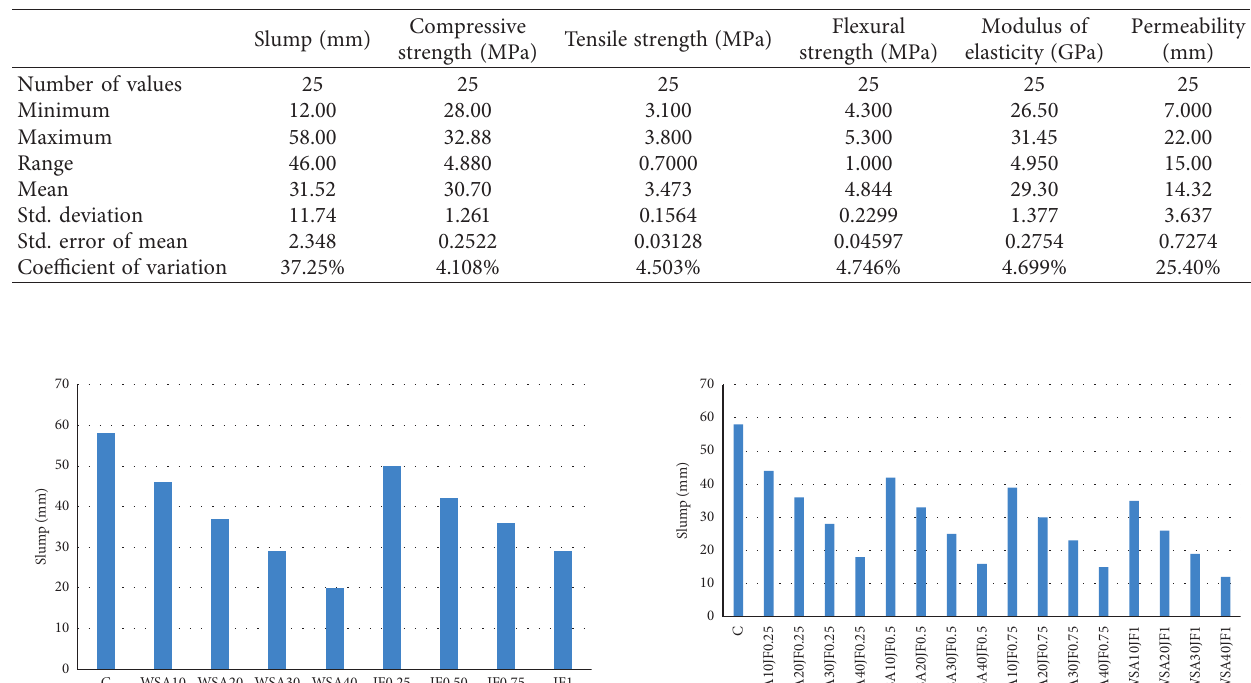
Table 4: Descriptive statistical data on experimental results.